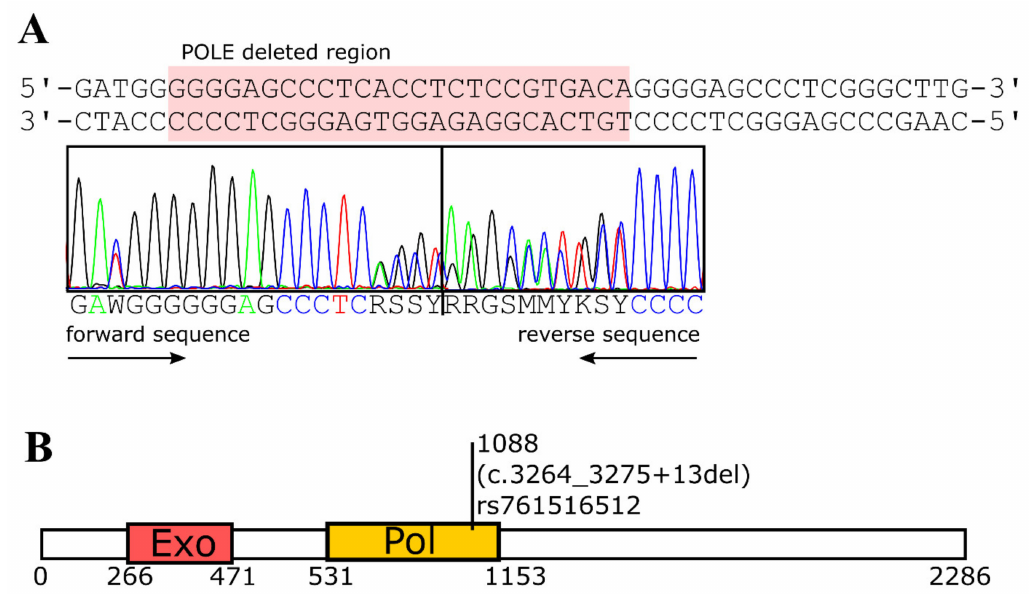
Figure 3. Sanger sequencing of POLE. ( A ) Sequencing shows the presence of POLE mutation in the germline corresponding to SNP rs761516512. ( B ) Schematic representation of POLE, indicating exonuclease (Exo) and polymerase (Pol) domains and the respective amino acid